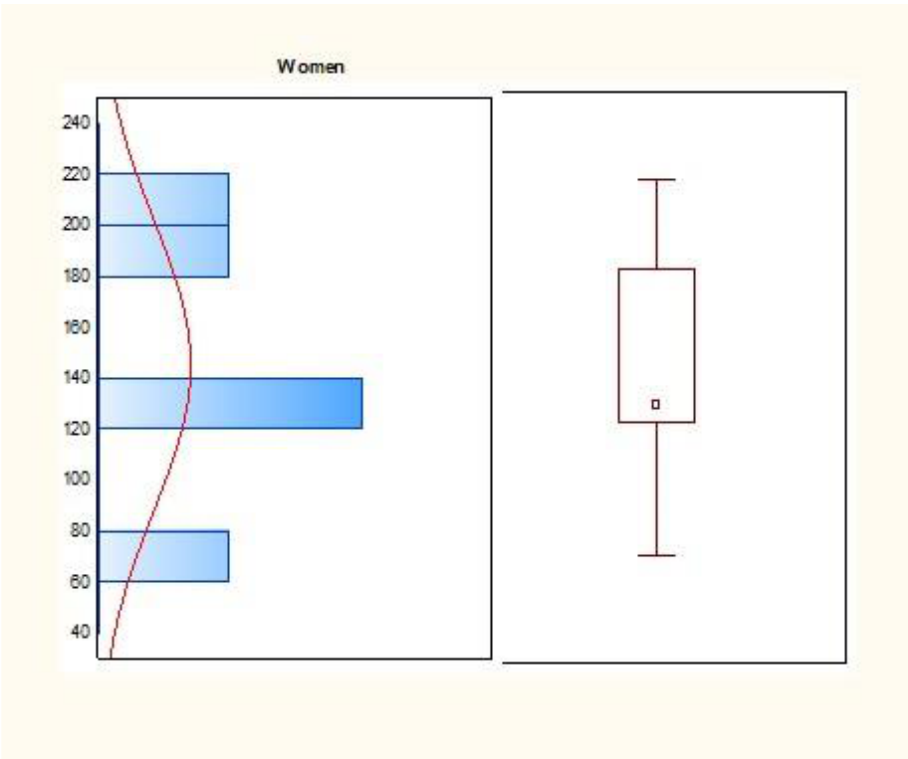
Figure 18. Employee structure by gender and performance data.